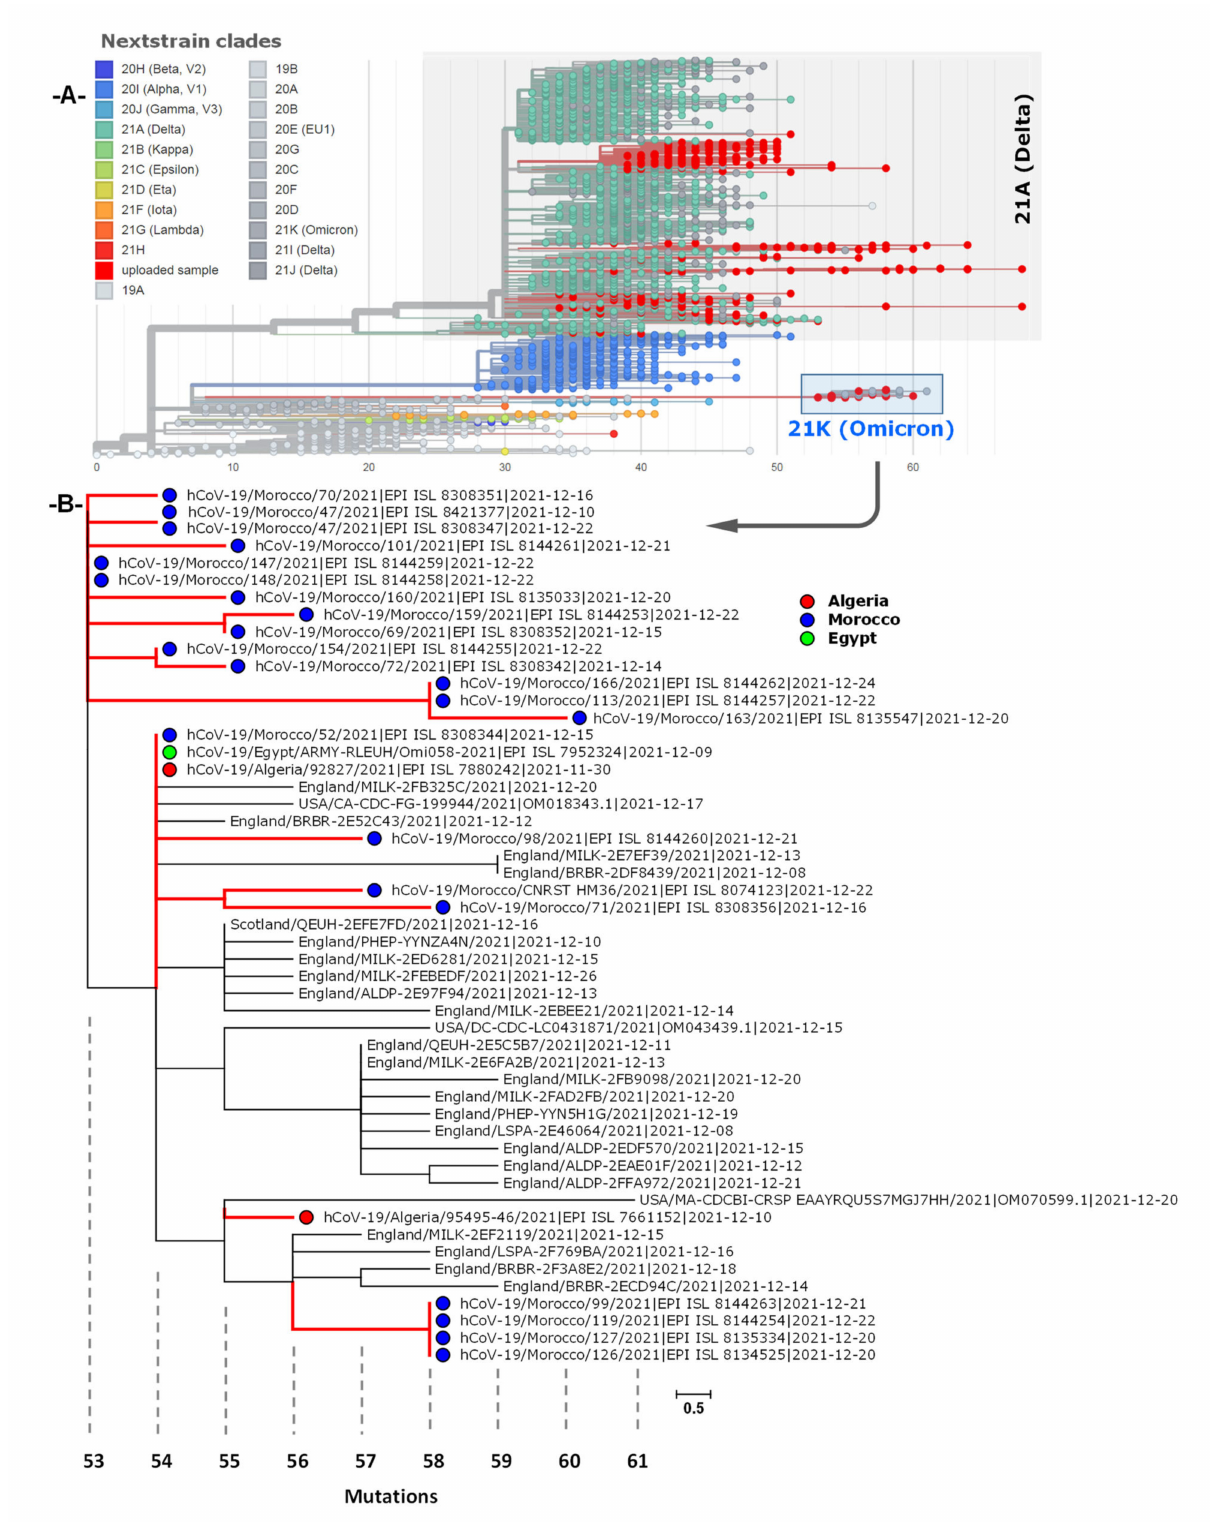
Figure 5. ( A ) Phylogenetic analysis generated by UShER interface of 350 SARS-CoV-2 sequences from North African countries. Subtrees including Omicron and Delta sequences plus 2031 random nearest sequences from the GISAID, GenBank, COG-UK, and CNCB databases (updated 30 December 2021). ( B ) Sequence comparison showing concordance, nucleic acid, and amino acid changes in the twenty- five Omicron sequences with respect to the SARS-CoV-2 Reference